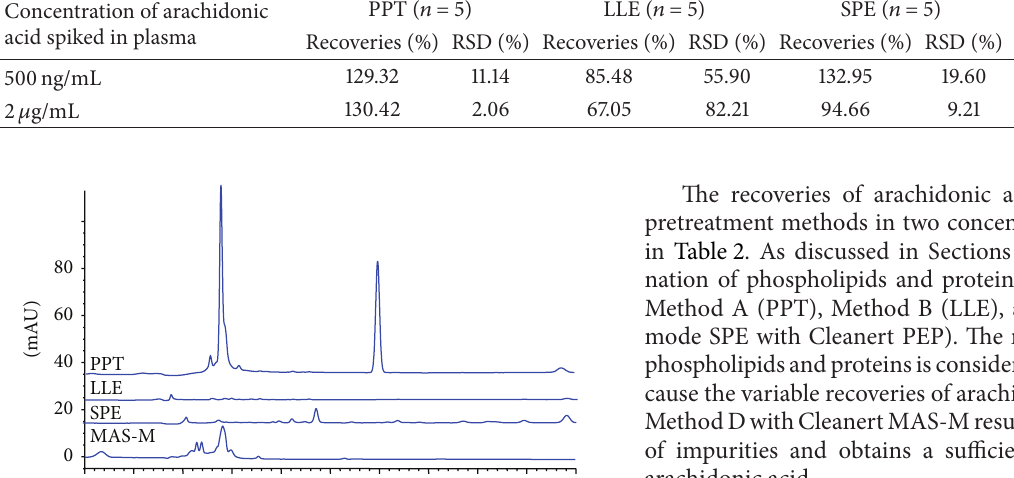
Table 2: Recoveries of arachidonic acid in spiked samples treated by four sample pretreatment methods. Concentration of arachidonic